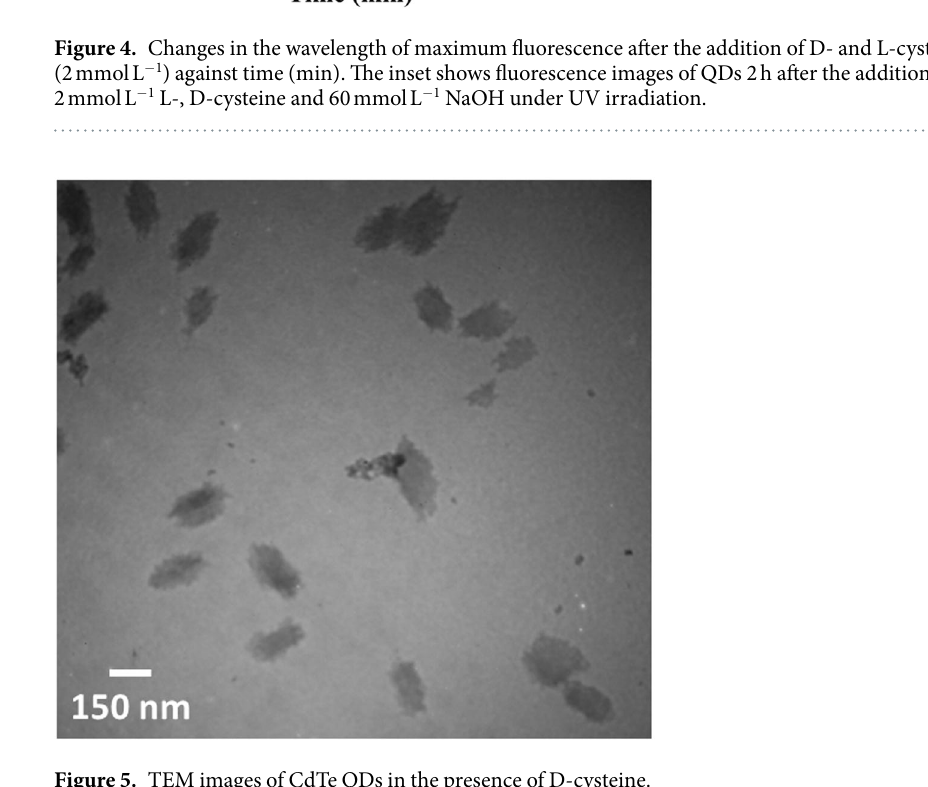
Figure 5. TEM images of CdTe QDs in the presence of